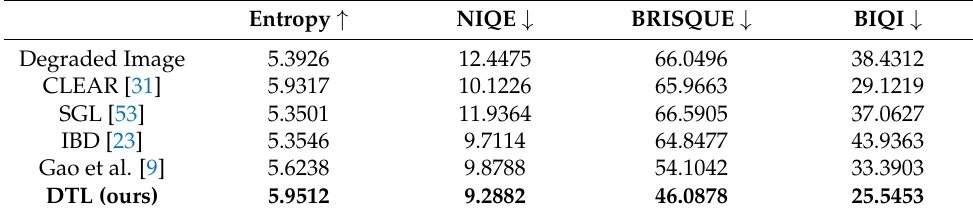
Table 5. Objective assessment of the above restoration methods.